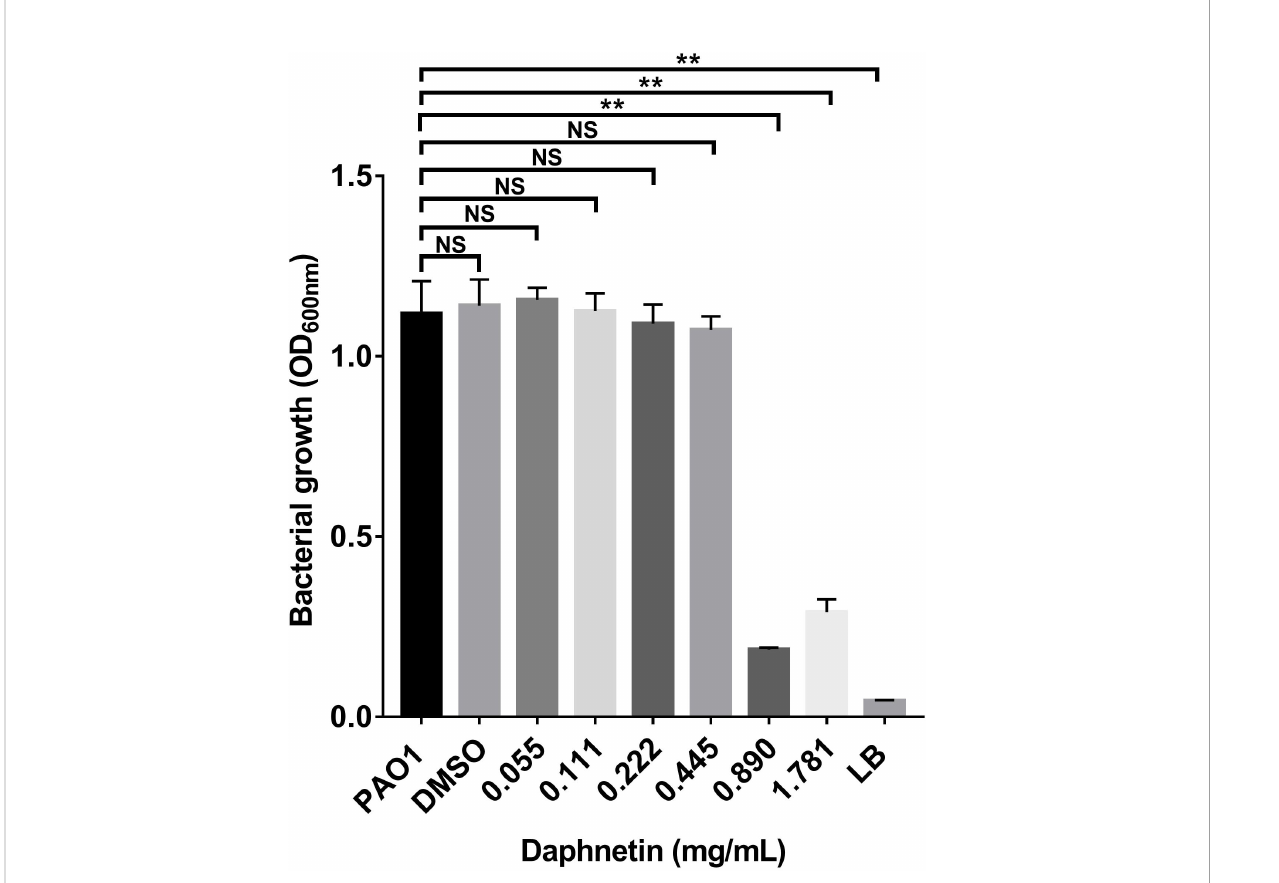
FIGURE 1 The minimal inhibitory concentration (MIC) of daphnetin (DAP) against planktonic Pseudomonas aeruginosa PAO1. The bacterial growth of Pseudomonas aeruginosa treated with varying concentrations of DAP (0.055 – 1.781 mg/mL) was evaluated using optical density (OD 600 nm). Experiments were performed in triplicate; NS indicates P-values of >0.05 and ** indicate P-values <0.01, relative to the PAO1 control (no